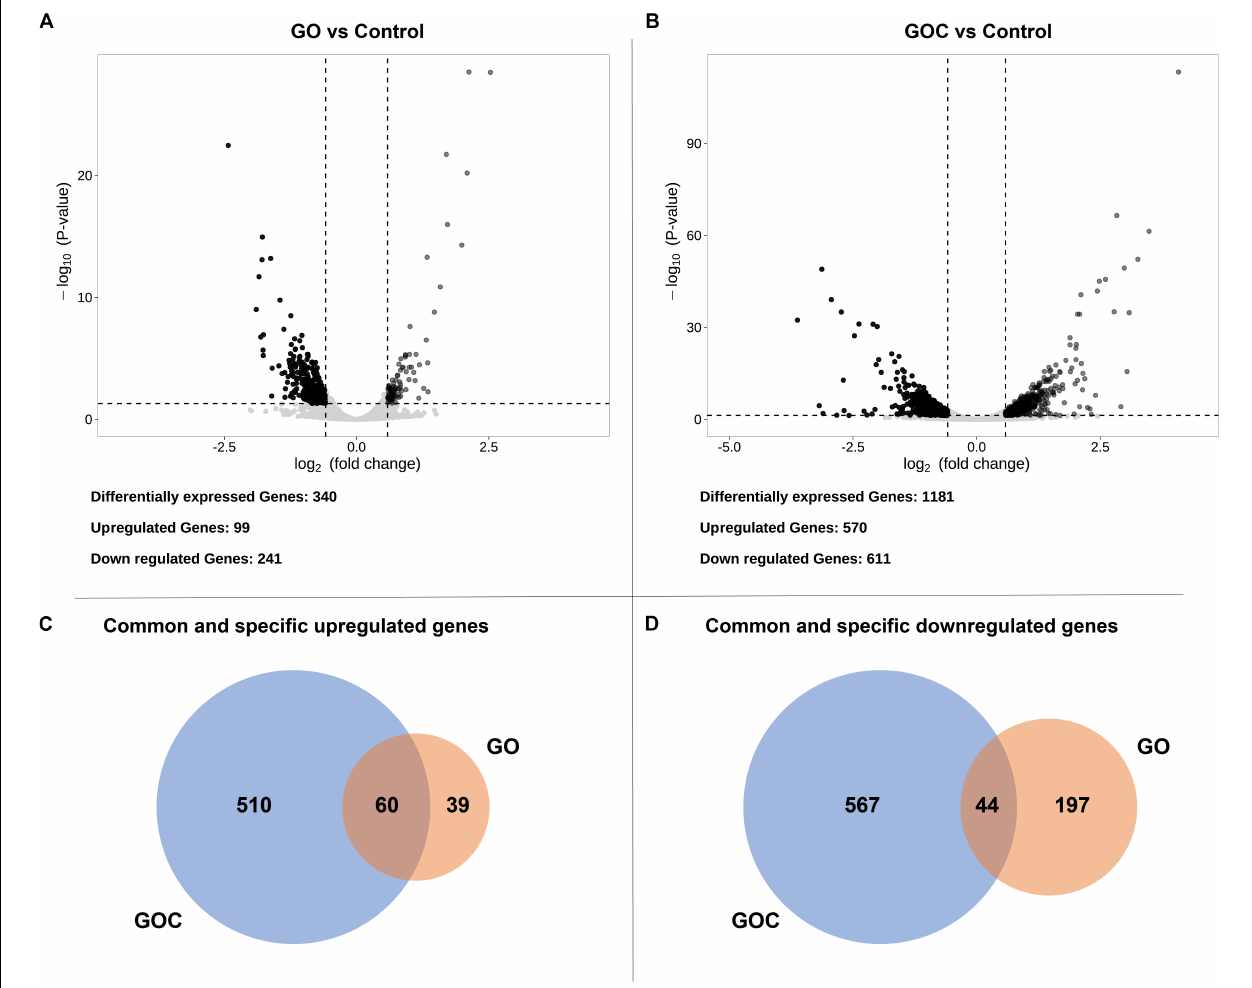
FIGURE 3 | Volcano plots displaying the fold change (log2) of differentially expressed genes of GO vs. the control (A) and GOC vs. the control (B) , and Venn diagrams showing common and specific upregulated (C) and downregulated (D) genes between the different exposure conditions. The genes were considered significantly differentially expressed if they had a fold change higher than 1.5 (upregulated) or lower than 1/1.5 (downregulated), and an FDR lower than